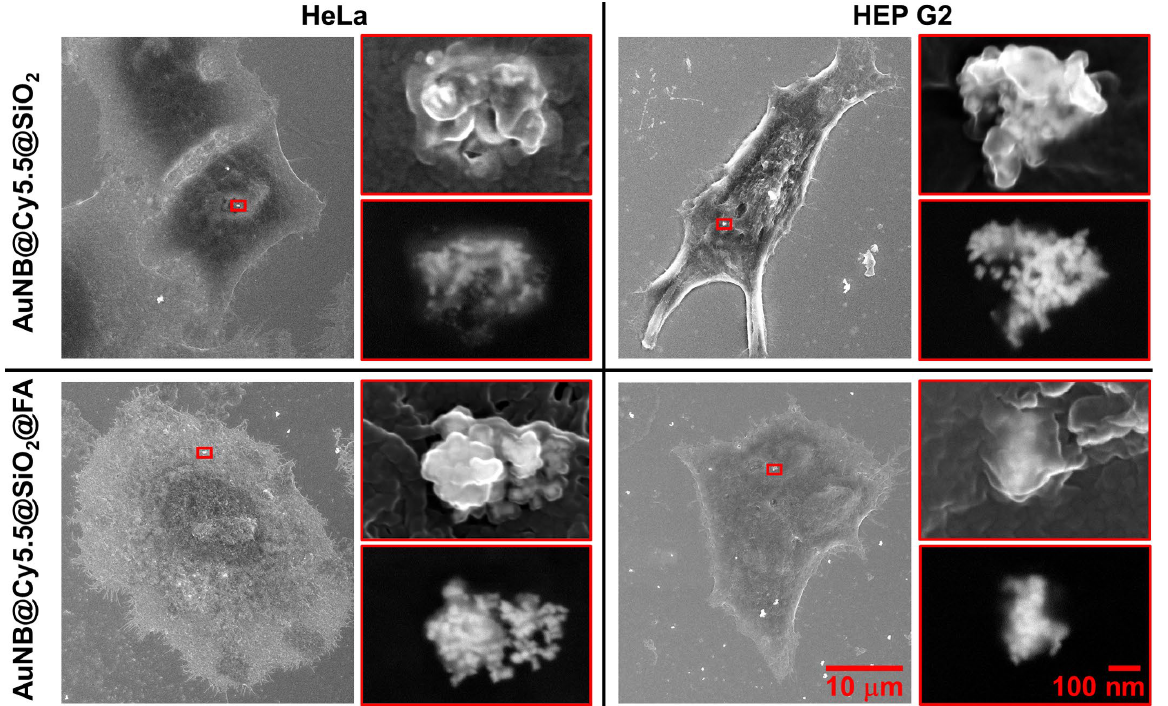
Figure 4. SEM images of HeLa and HEP G2 cells after incubation with nanotags. The large images show a general view of the cell in InLens mode. Two images on the right are the enlarged area with nanoparticle agglomerates highlighted with a red frame. The top image in each case was obtained in InLens mode, and the bottom image was obtained in AsB mode. All series have the same scale bar indicated bottom right.